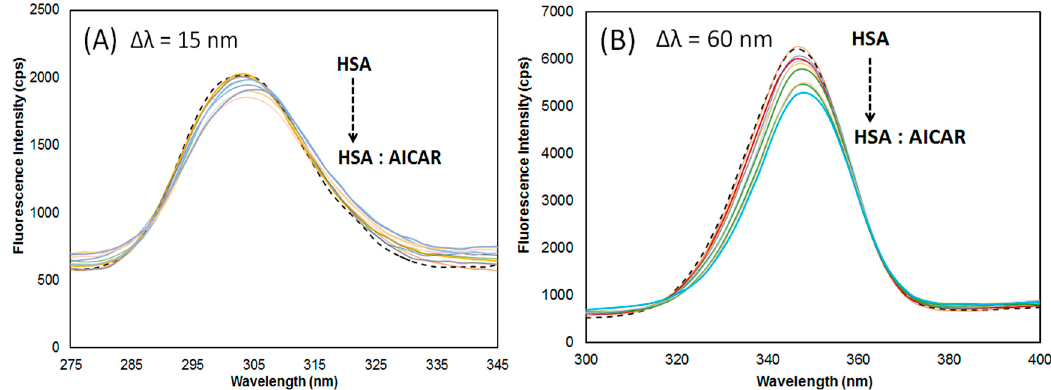
Figure4. SynchronousfluorescencespectraofAICAR–HSAcomplexwithvaryingAICARconcentration Figure 4. Synchronous fluorescence spectra of AICAR–HSA complex with varying AICAR concentration (5–50 µ M) and fixed HSA concentration (5 µ M); ( A ) ∆ λ = 15 nm, and ( B ) ∆ λ = 60 nm, at pH 7.4 and (5–50 μ M) and fixed HSA concentration (5 μ M); ( A ) Δλ = 15 nm, and ( B ) Δλ = 60 nm, at pH 7.4 and 298 K. 298 Table 4. The synchronous fluorescence data for HSA and AICAR–HSA (1/1 ratio) ( A ) Δλ = 15 nm, and ( B ) Δλ = 60 nm.